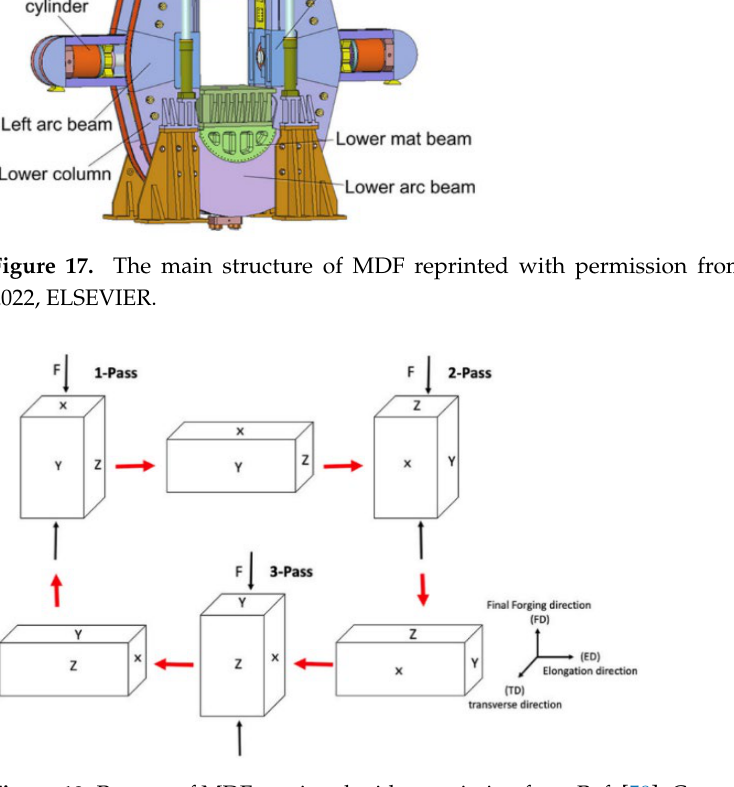
Figure 18. Process of MDF reprinted with permission from Ref. [59]. Copyright 2022 ELSEVIER.